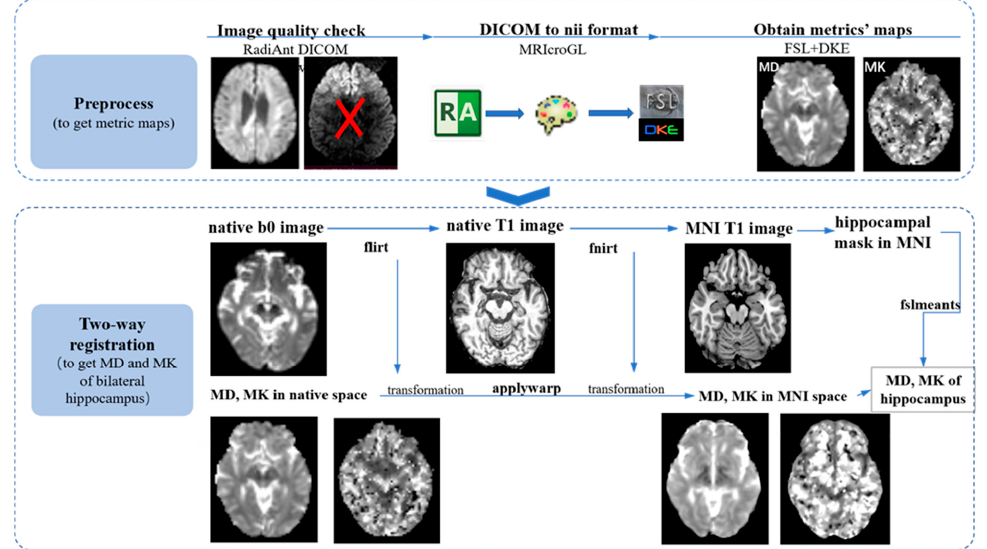
Figure 3. The flowchart of imaging processing. The image processing pipelines are mainly divided into three steps: preprocessing step (this mainly includes visual image quality checking using the software RadiAnt DICOM Viewer (https://www.radiantviewer.com/, accessed on 20 April 2022), converting the image format from DICOM into NIFIT using MRIcroGL; obtaining measurement maps using FSL and DKE together); and two-way registration (MD and MK maps were normalized into standard space using FSL based on Linux system. Firstly, the b0 image was registered into native T1 space using “flirt”; secondly, native T1 was normalized into MNI T1 space using “fnirt”; thirdly, the transformations from the last two steps were applied to native MD/MK and aligned into standard space and extraction of values using “fslmeants”.